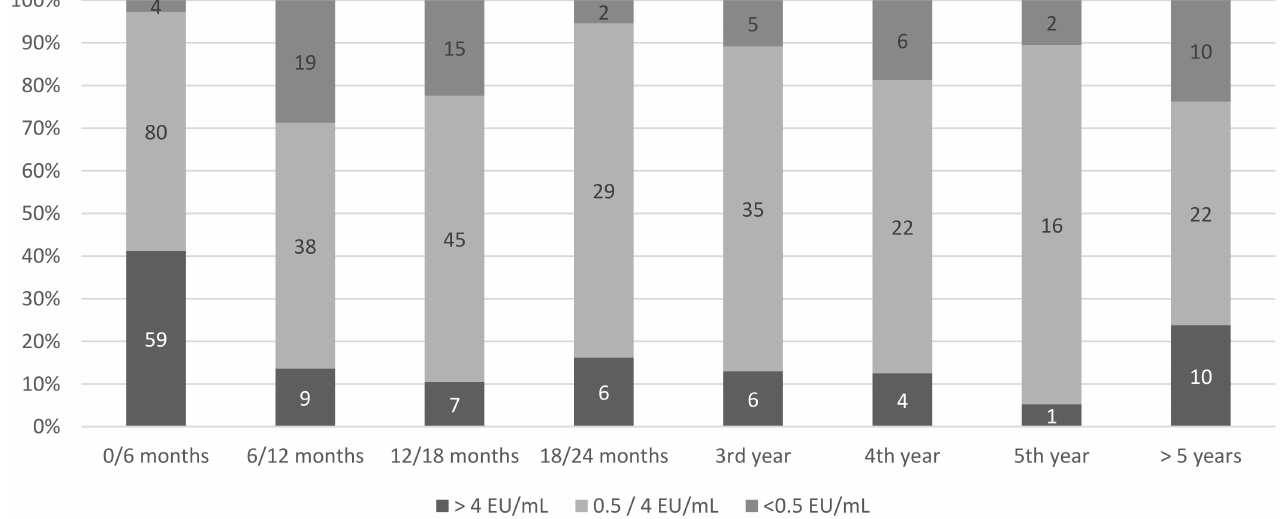
Figure 2. Percentage and number of antibody titers assessed after rabies primary vaccination by titer categories and time-lapse since primary vaccination, in individuals vaccinated for occupational purposes ( n = 452), Institut Pasteur, Paris 2000–2015. Table 2. Variables associated with antibody titers considered protective (“adequate”) or nonprotective (“inadequate”) on first assessment after rabies pre-exposure prophylaxis (univariate and